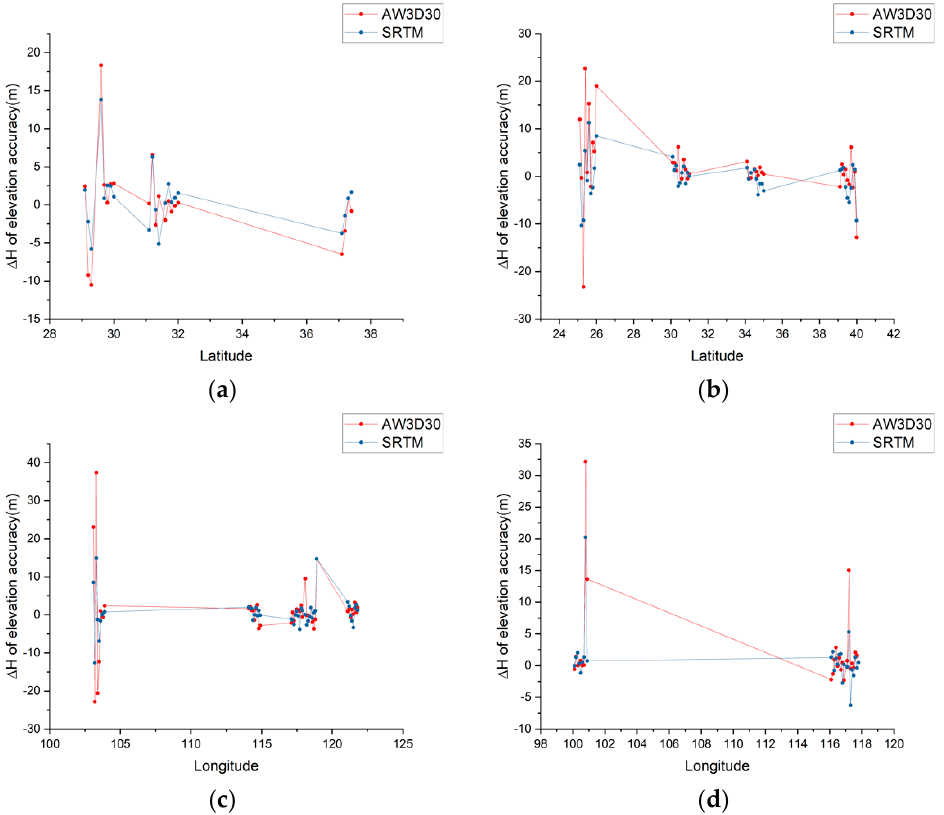
Figure 9. ∆ H (elevation error) of AW3D30 and SRTM with respect to latitude and longitude: ( a ) was drawn with reference points along 121.5°E in Ningbo (29°N), Pudong (31°N), and Yantai (37°N), ( b ) was drawn with reference points along 113°E in Ganzhou (25°N), Wuhan (30°N), Zhengzhou (34°N), and Fangshan (39°N), ( c ) was drawn with reference points along 31°N in Chengdu (103°E), Wuhan (114°E), Hefei (117°E), Nanjing (118°E), and Pudong (121°E), ( d ) was drawn with reference points along 39°N in Zhangye (100°E), Fangshan (116°E), and Beichen (117°E).